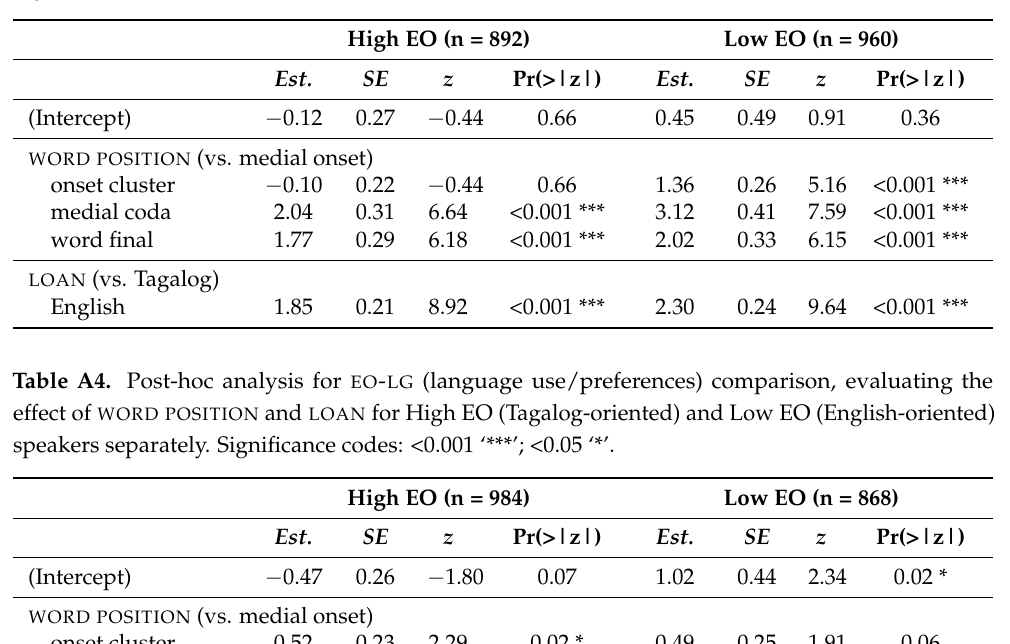
Table A3. Post-hoc analysis for EO - ID (ethnic identity) comparison, evaluating the effect of WORD PO - SITION for High EO (Filipino-oriented) and Low EO (Canadian-oriented) heritage speakers separately. Significance code: <0.001 ‘***’.